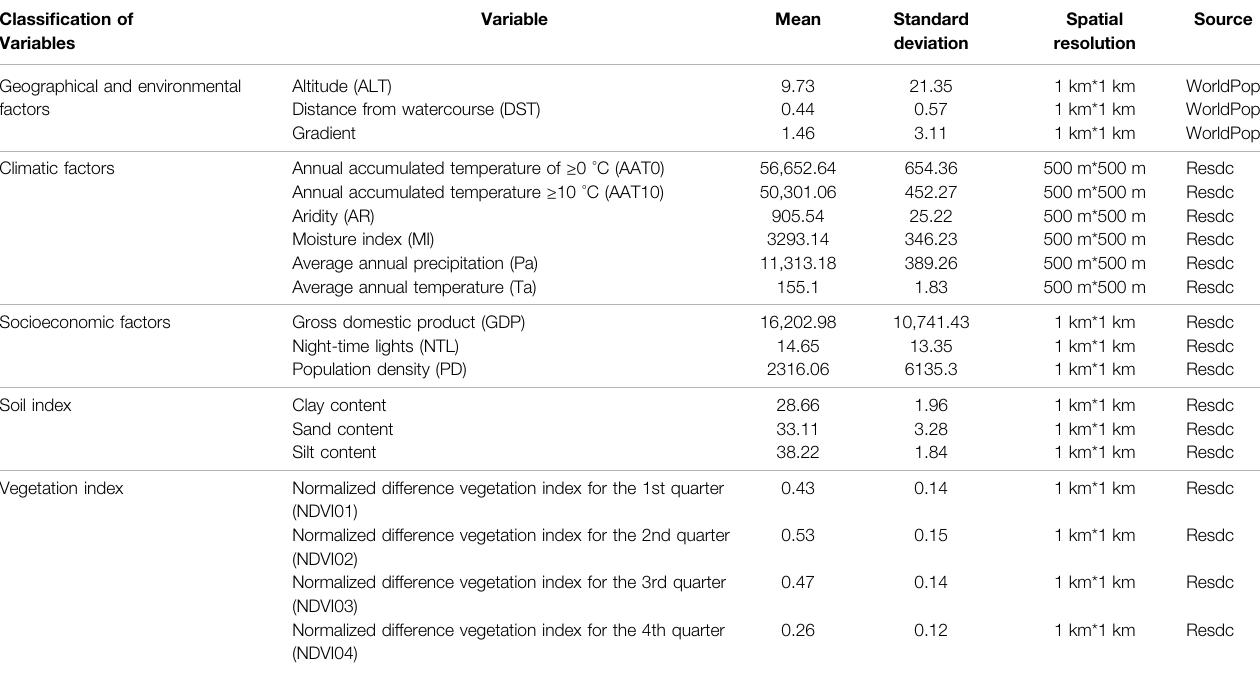
TABLE 1 | Variables included for using the fi ve ecological niche models for prediction of potential Oncomelania hupensis distribution in Suzhou City from 2016 to 2020. Classi fi cation of